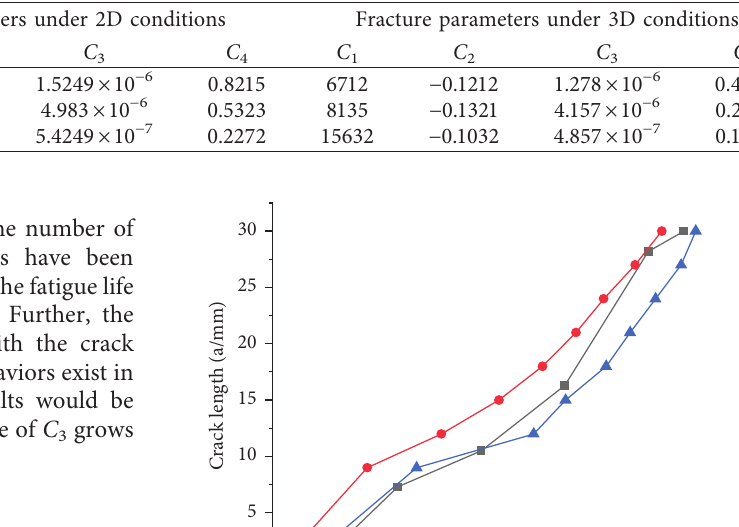
Table 4: Model fracture performance parameters.